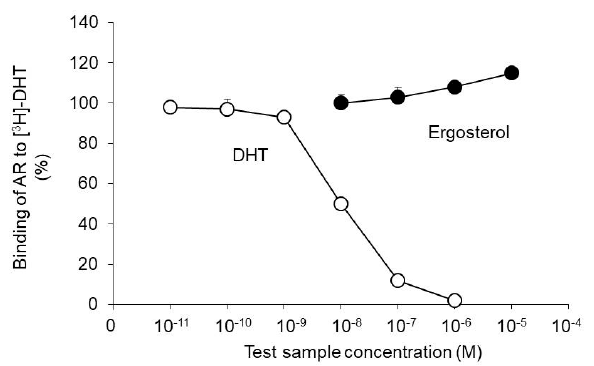
Figure 6. Effect of ergosterol on the binding properties of AR and dihydrotestosterone (DHT). Maltose binding protein-fused human AR ligand-binding domain (MBP-hAR-LBD) and [1,2,4,5,6,7-3H] 5 α -dihydrotestosterone ([3H]-DHT) were incubated with ergosterol or DHT. The radioactivity of [ 3 H]-DHT bound to AR was measured using a liquid scintillation counter. The data show the mean ± SD from five experiments.